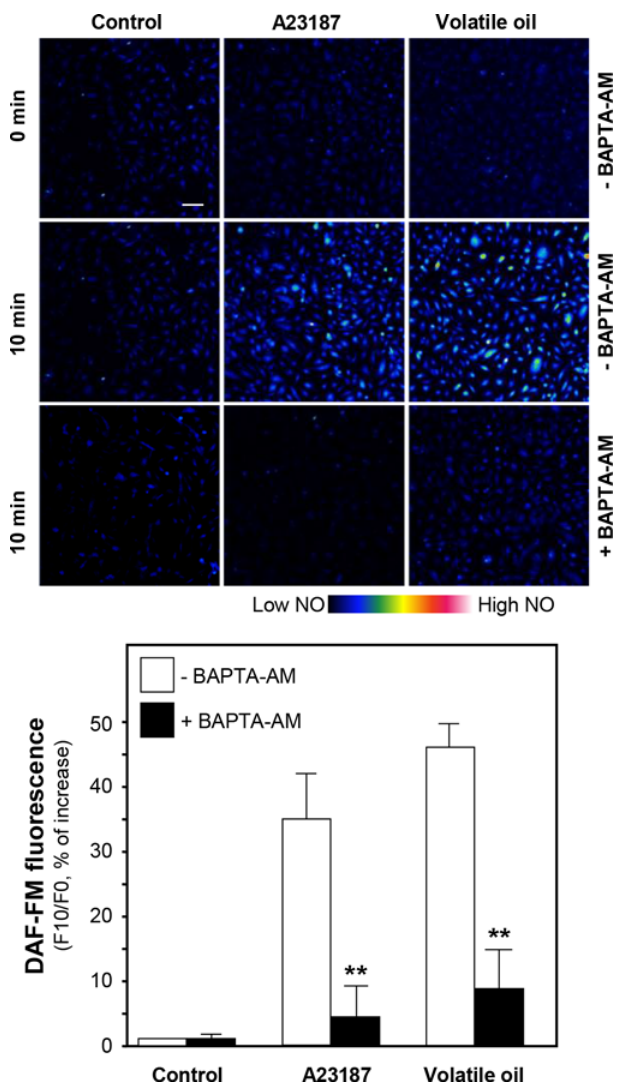
Figure 8. Volatile oil-induced NO production is blocked by BAPTA-AM. Cultured HUVECs were pre- treated with serum free medium or BAPTA-AM (5 µ M) for 3 hours, and then labeled with fluorescent NO indicator DAF-FM DA for 30 min. Fluorimetric measurement was performed after the treatment of NRR volatile oil (25 µ g/mL), A23187 (1 µ M, positive control). The amounts of NO were evaluated by measuring the fluorescence intensity. Micrographs were taken by the confocal microscope. Bar = 100 µ m (upper panel). Quantification of NO production was displayed as a ratio of fluorescence intensity at 10 min (F10) to the control at time 0 (F0) in the cultures (lower panel). Mean ± SEM, n = 3, each with triplicate samples. ** p < 0.01.